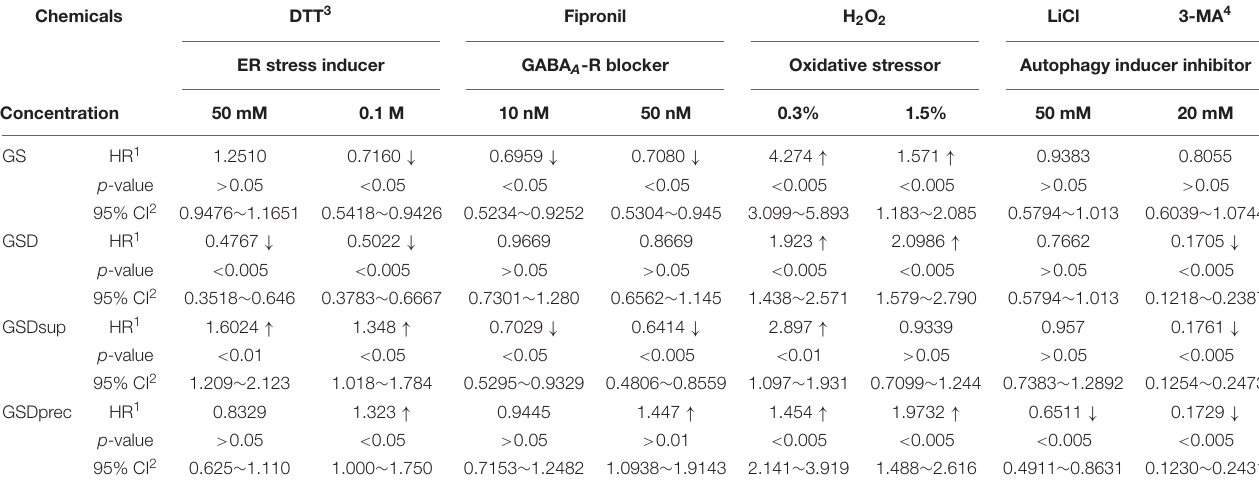
TABLE 1 | Altered susceptibility of GS feed (GSf)-, GSD feed (GSDf)-, GSD supernatant feed (GSDsupf)-, and GSD precipitate feed (GSDprecf)-reared Drosophila to various signal transduction pathway modulators.